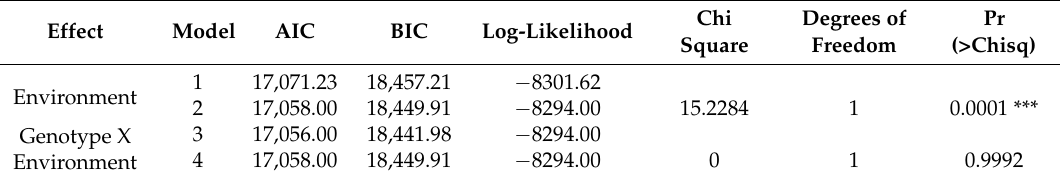
Table 3. Testing for significance of fertilizer and its combined effect with genotype using − 2 log- likelihood ratio test.